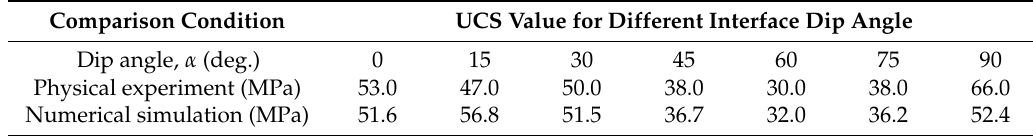
Table 4. Comparison of UCS values between physical experiment and numerical simulation